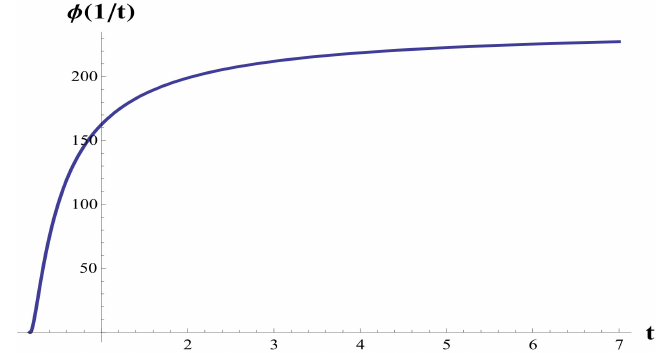
Figure 3. Numerical profile of φ ( 1/ t ) corresponding to a ( t ) given in Figure